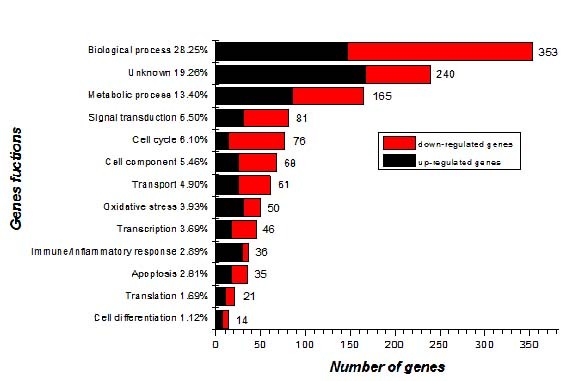
Functional categorization of 1246 genes. Genes were functionally classified based on the ontology-driven clustering approach of PANTHER.